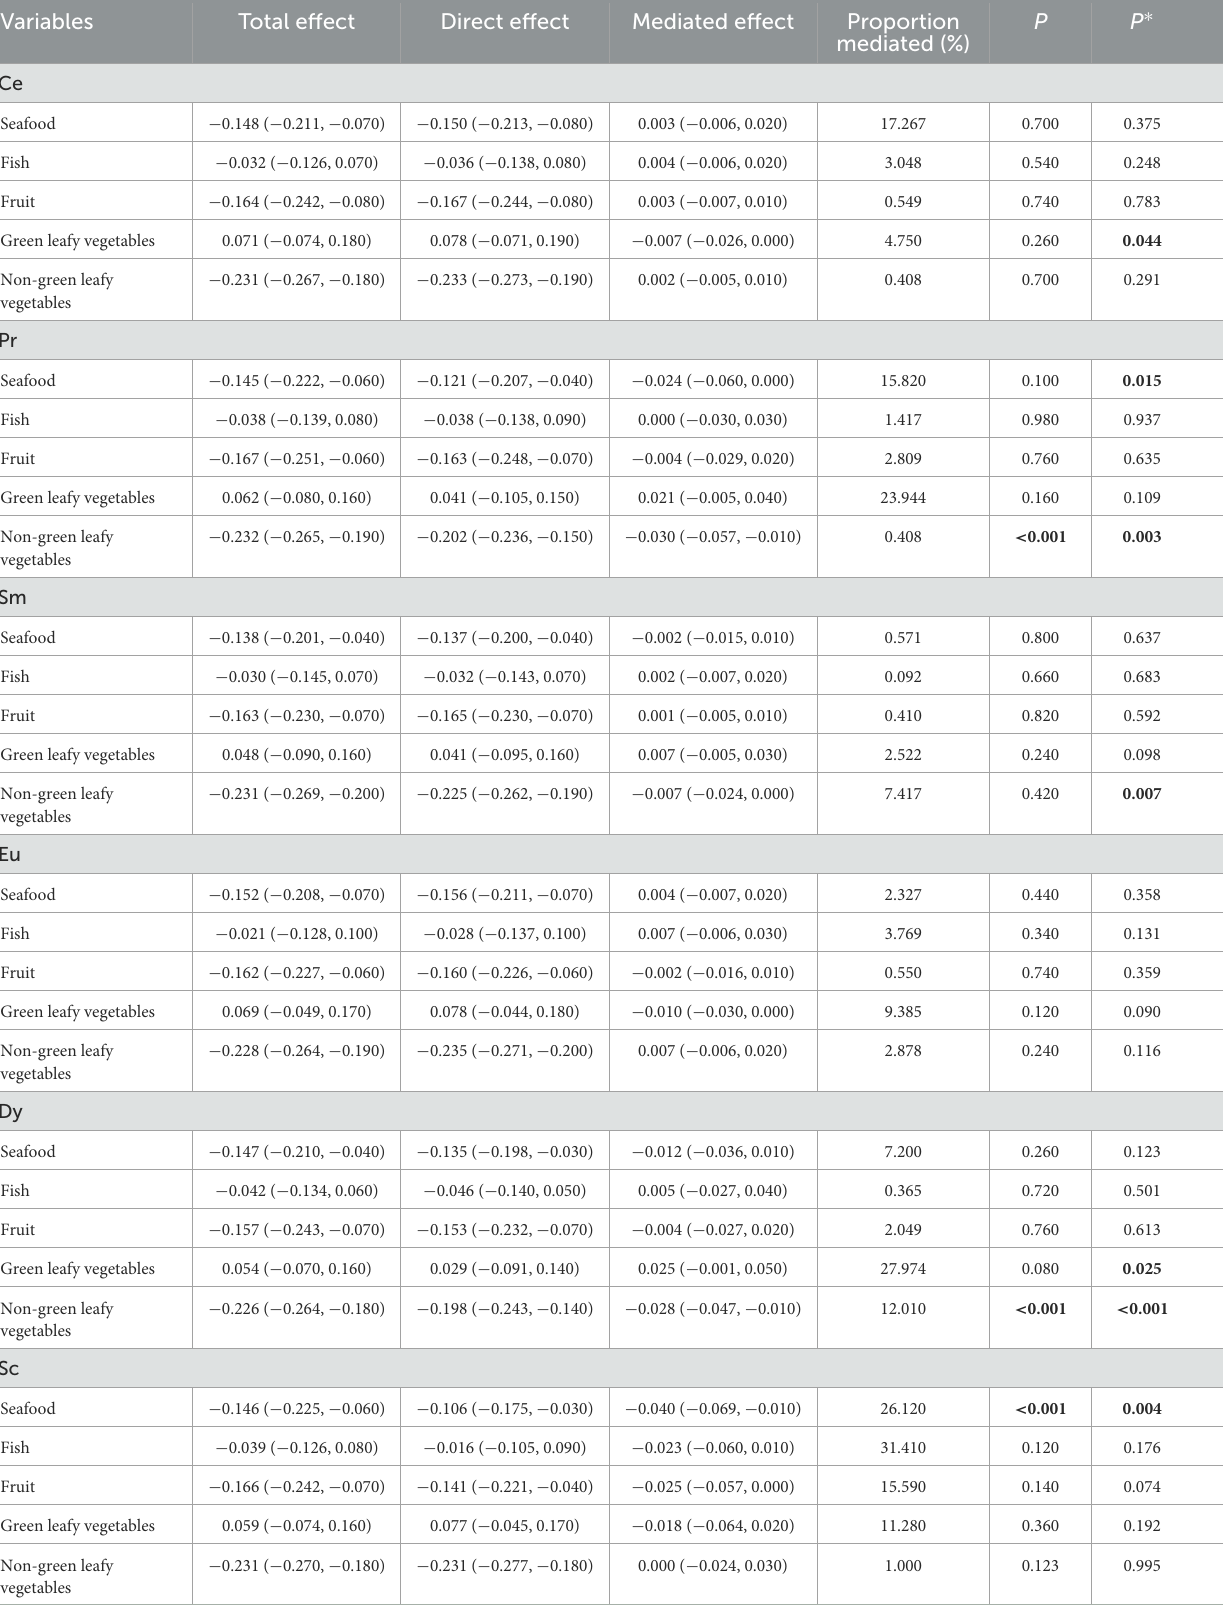
TABLE 3 The mediation effect of the REE and food categories for tongue